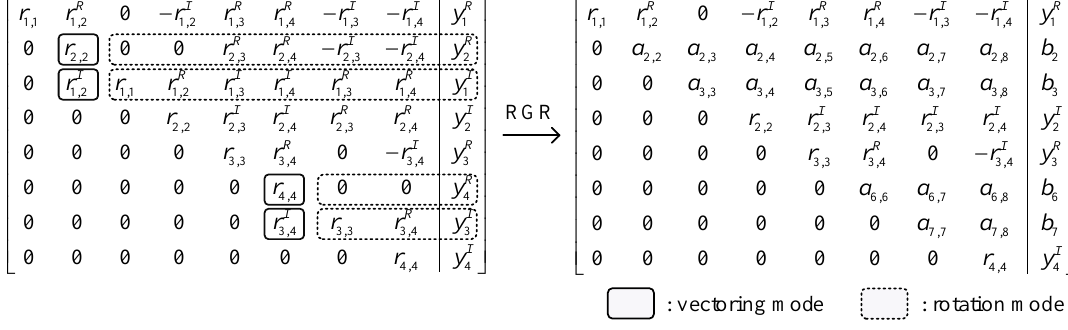
Figure 4. The processing diagram of real Givens rotation (RGR) for 4 × 4 MIMO system.